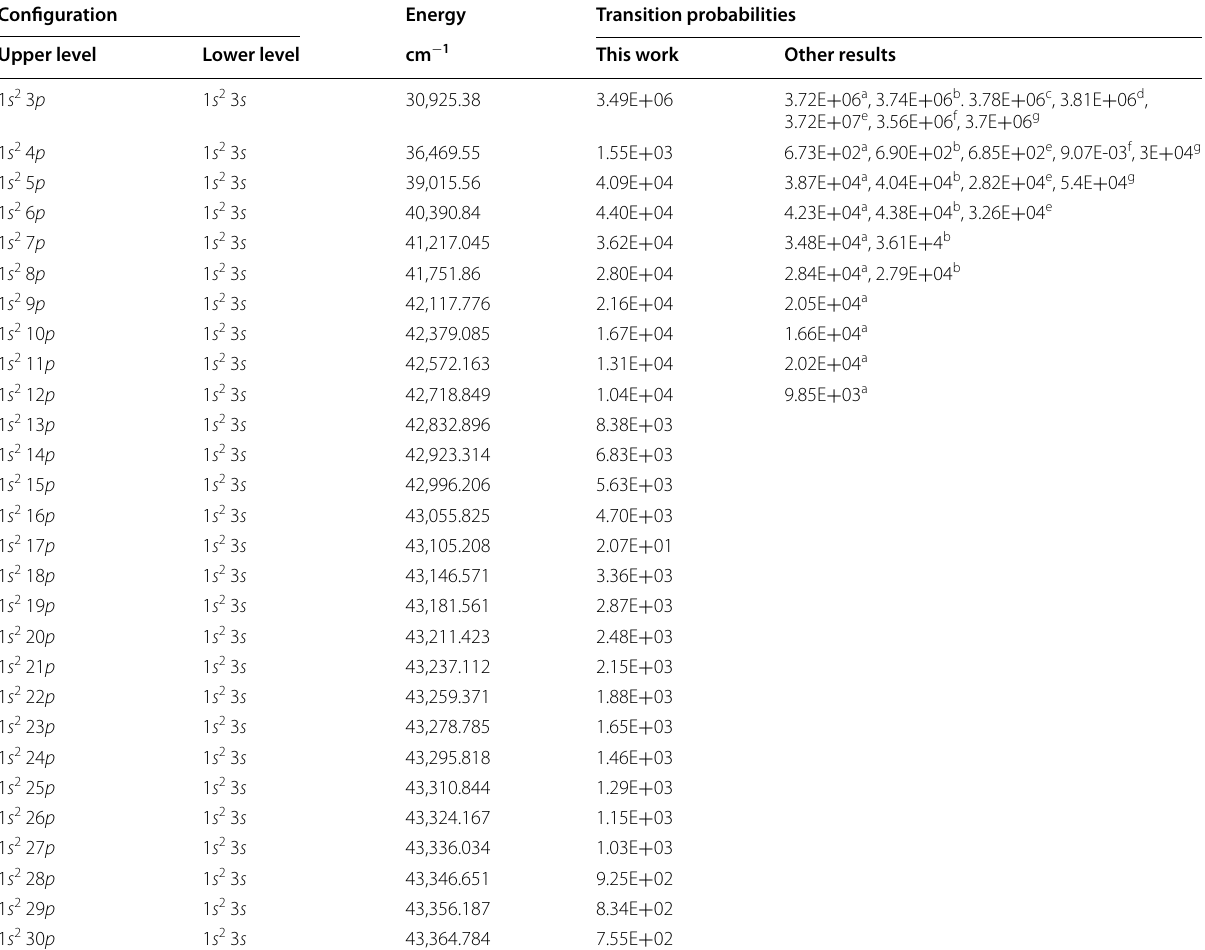
Table 2 Transition probabilities for the transitions 1 s 2 np –1 s 2 3 s calculated in this work compared with other